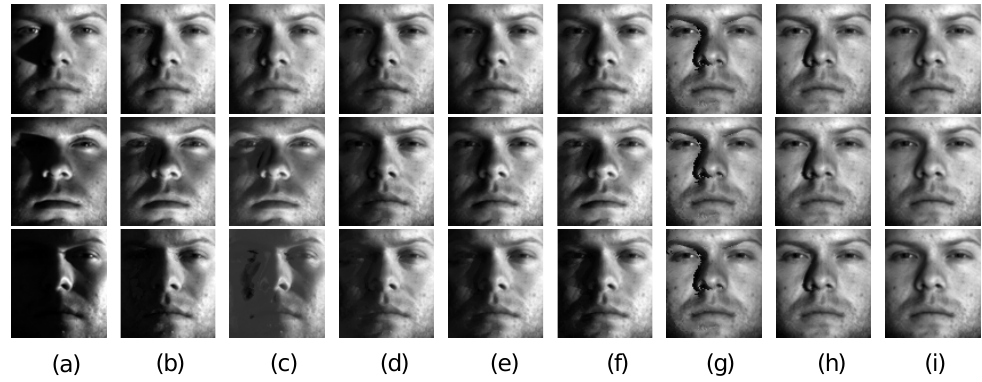
Figure 10. Removing shadows and specularities from face images. ( a ) Cropped and aligned images from the Extended Yale B database of a person’s face under different illumination. The size of each image is 96 × 84 pixels and 20 different illumination settings in total were used for the person. Low-rank term X obtained by RPCA ( b ), LR-MDL ( c ), CoGEnT ( d ), BSGFL ( e ), PSSV ( f ), ROUTE ( g ), FGSR ( h ) and the proposed approach ( i ).